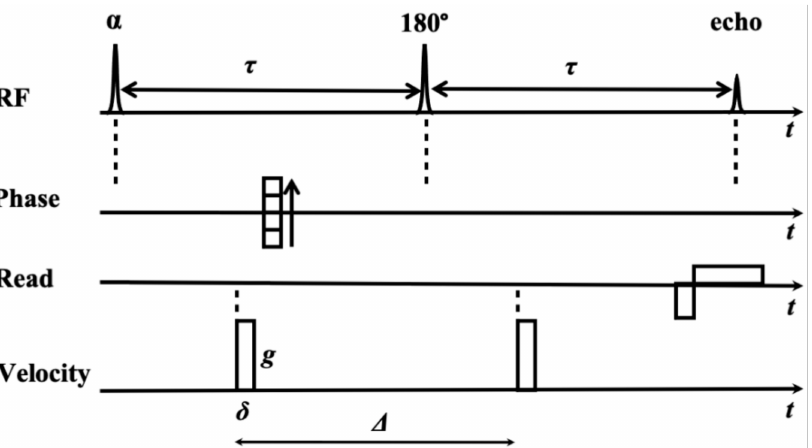
Figure 2. Implemented single-SE PC MRV pulse sequence for 3D MRV of methane in the monoliths (not to scale). For slice-selective 2D imaging, soft RF pulses with slice-selection and slice-rephasing gradients in the slice direction are used instead of rectangular RF pulses, and phase encoding is only performed in one